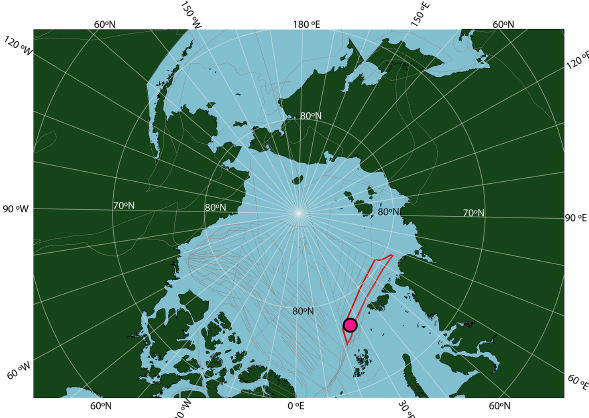
Figure 1. Location of ACEX Hole 4A within a paleogeographic reconstruction of the Arctic region at the time of the PETM. Recon- struction made using gplates (Müller et al., 2018), with the tectonic reconstruction of Seton et al. (2012), the paleomagnetic reference frame of Torsvik et al. (2012) and modern coastlines. The red shape is Lomonosov Ridge in this reconstruction, and grey lines are struc- tural features including spreading